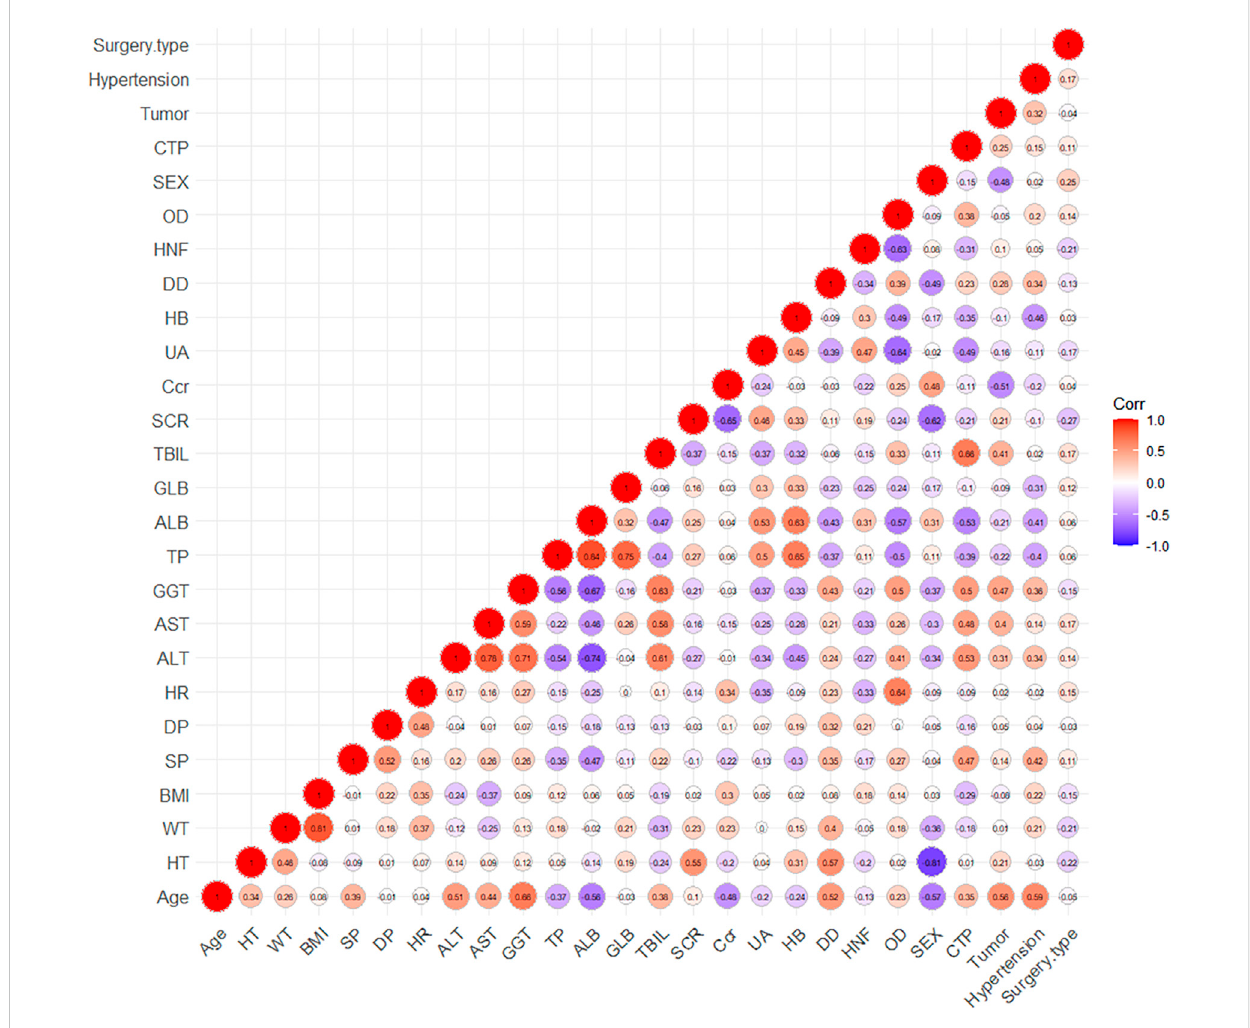
FIGURE 3 The graph of correlation between